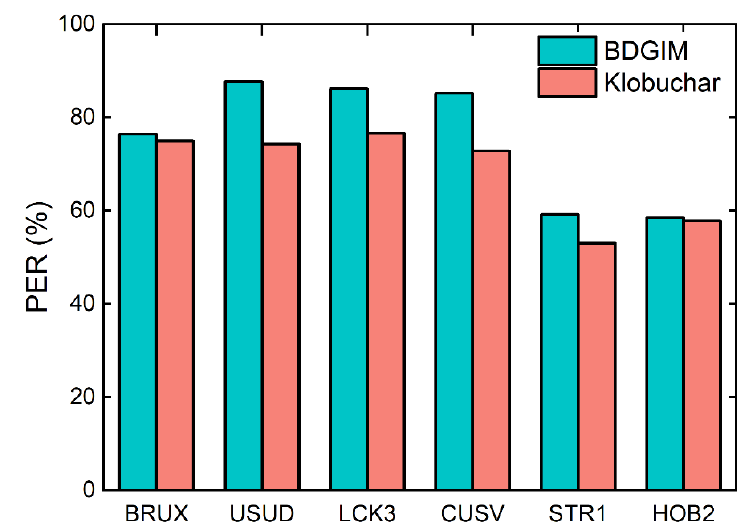
Figure 4. RMS errors of dVTEC between the broadcast ionosphere model and GIM.